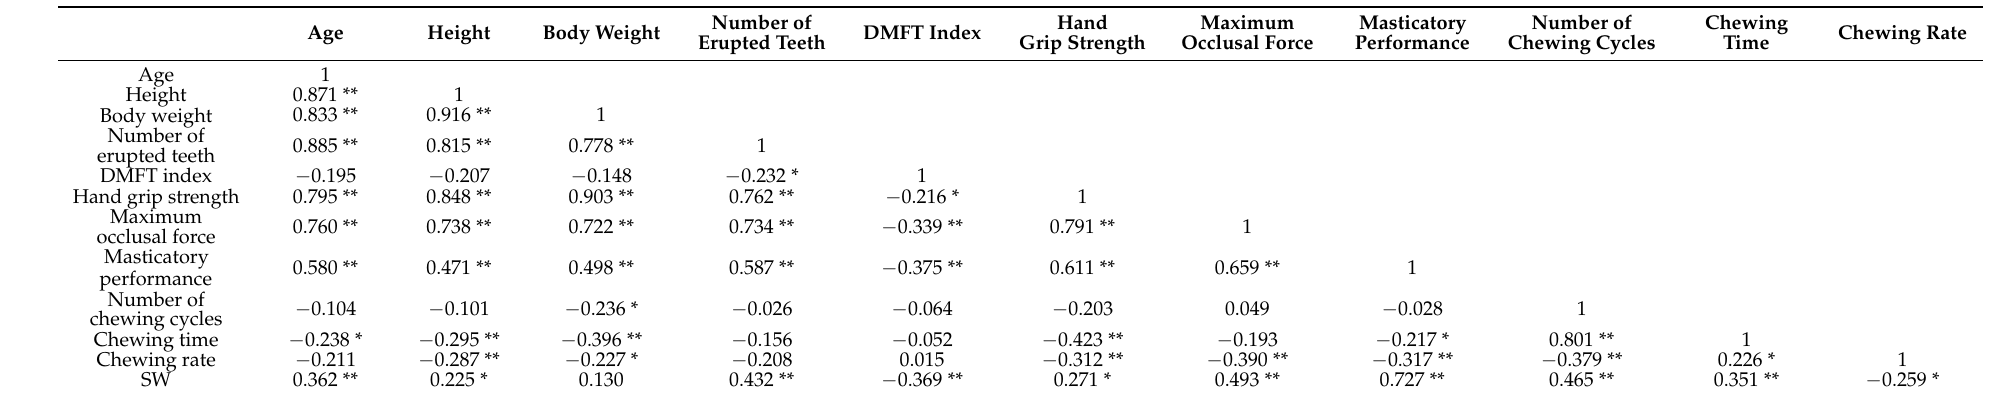
Table 3. Bivariate correlation coefficients for the anthropometry, dental status, and masticatory function. Age